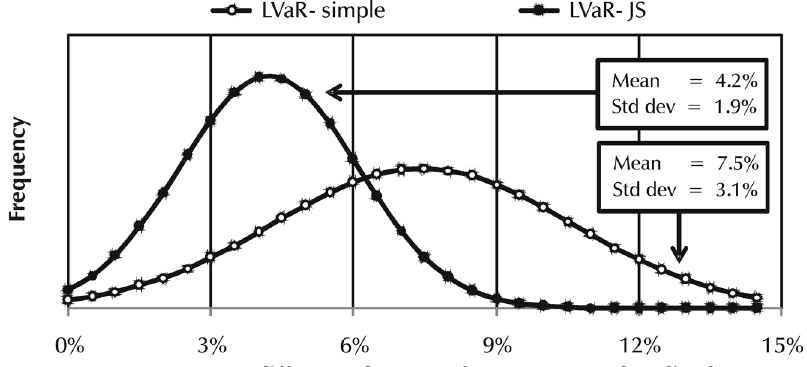
Comparison of VaR forecast versus realised P&L for both LVaR For all portfolios, the latter’s estimated losses were more accurately